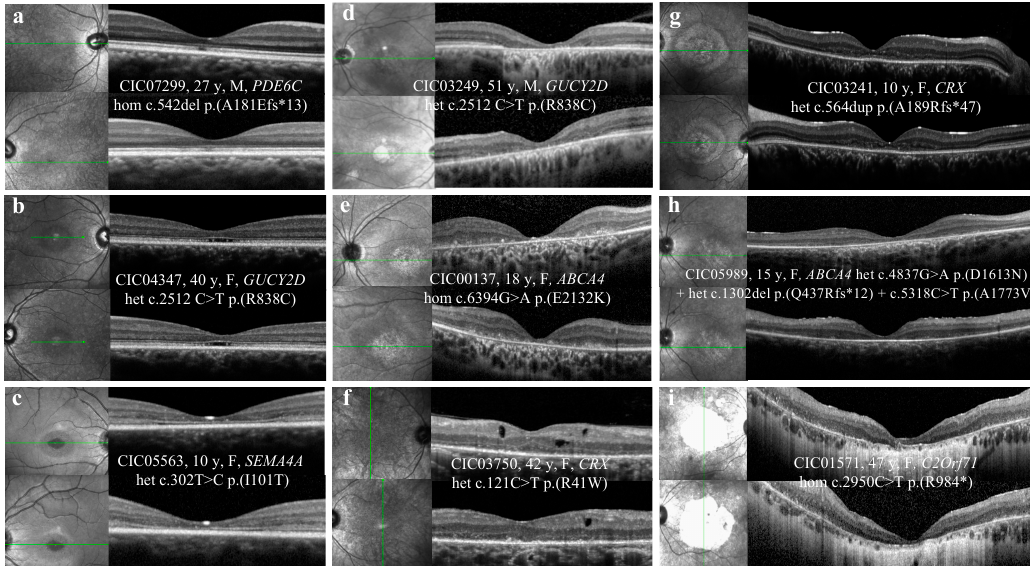
Figure 2. SD-OCT abnormalities observed in COD / CORDs patients of the cohort. ( a ) Abnormalities limited to the foveal region, irregular aspect or disruption of the ellipsoid zone (EZ) and the interdigitation zone (IZ). ( b ) Hyporeflective foveal cavitation. EZ and IZ are disrupted, while ELM and RPE layers are respected. ( c ) Perifoveal and foveal abnormalities. EZ and IZ are disrupted, while ELM is respected. ( d ) Outer retinal atrophy of the foveal and perifoveal regions. ( e ) Hyper-reflective deposits above the RPE in the foveal and perifoveal regions. ( f ) Hyporeflective cysts at the level of the outer and inner nuclear layers without macular edema. ( g ) Foveal sparing of the outer hyper-reflective layers; visual acuity is quite preserved for this patient (20 / 63 OD, 20 / 80 OG). ( h ) Outer retinal atrophy of the macular region. ( i ) Extensive chorioretinal atrophy with retinal thinning of the foveal region and choroidal hyperreflectivity by window defect. SD-OCT: spectral-domain optical coherence tomography; COD / CORDs: cone and cone-rod dystrophy; EZ: ellipsoid zone; IZ: interdigitation zone; ELM: external limiting membrane; RPE: retinal pigment